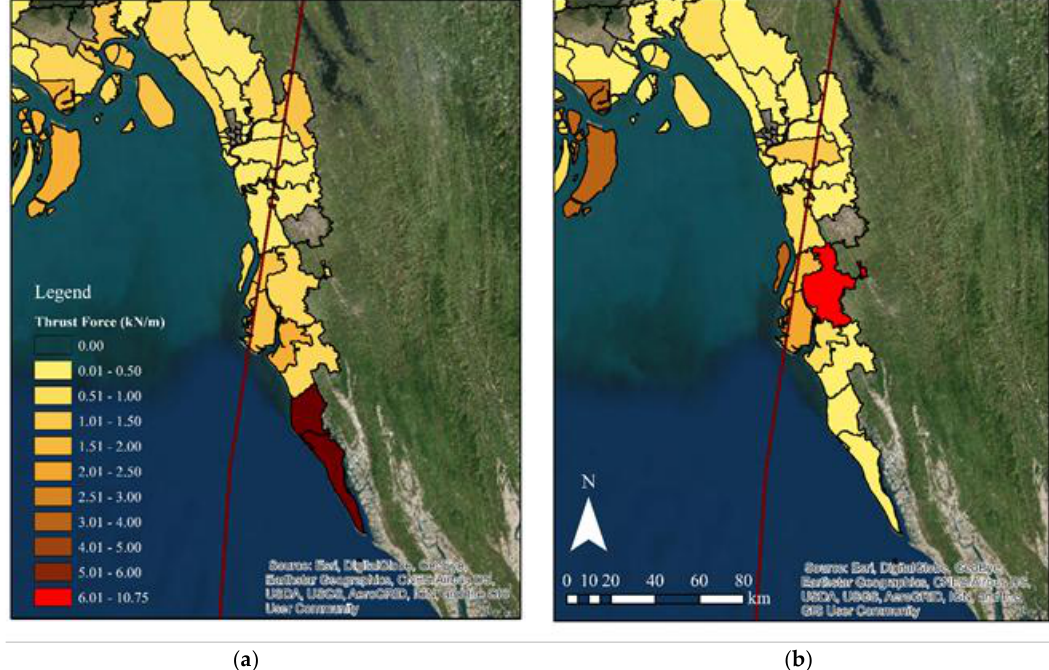
Figure 11. Distribution of thrust force at the time of landfall during ( a ) TC Mora, and ( b ) synthetic